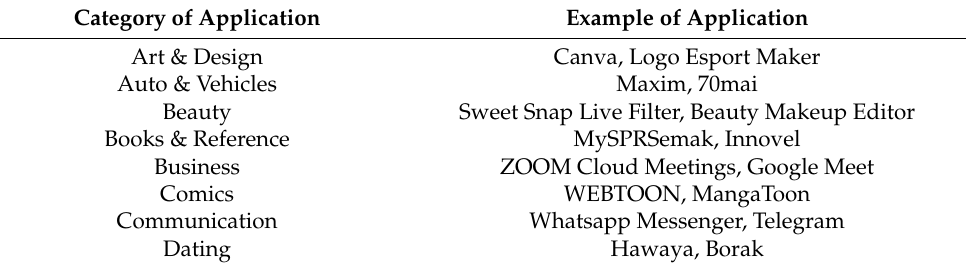
Table 1. Categories of applications and their examples